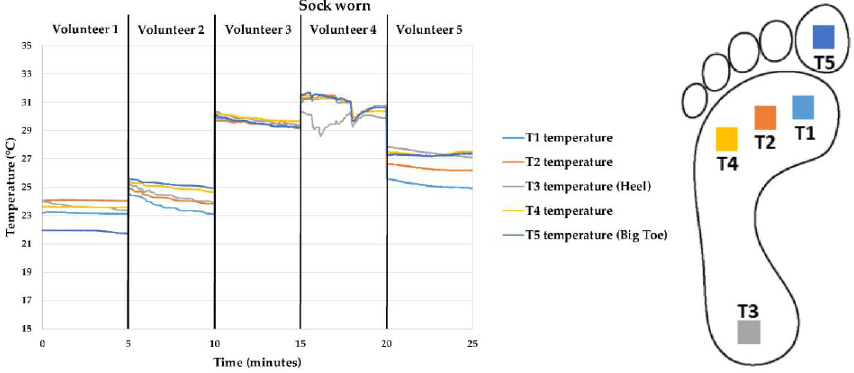
Figure 9. Temperature measurements from the temperature sensing sock when the sock was worn by each of the volunteers.